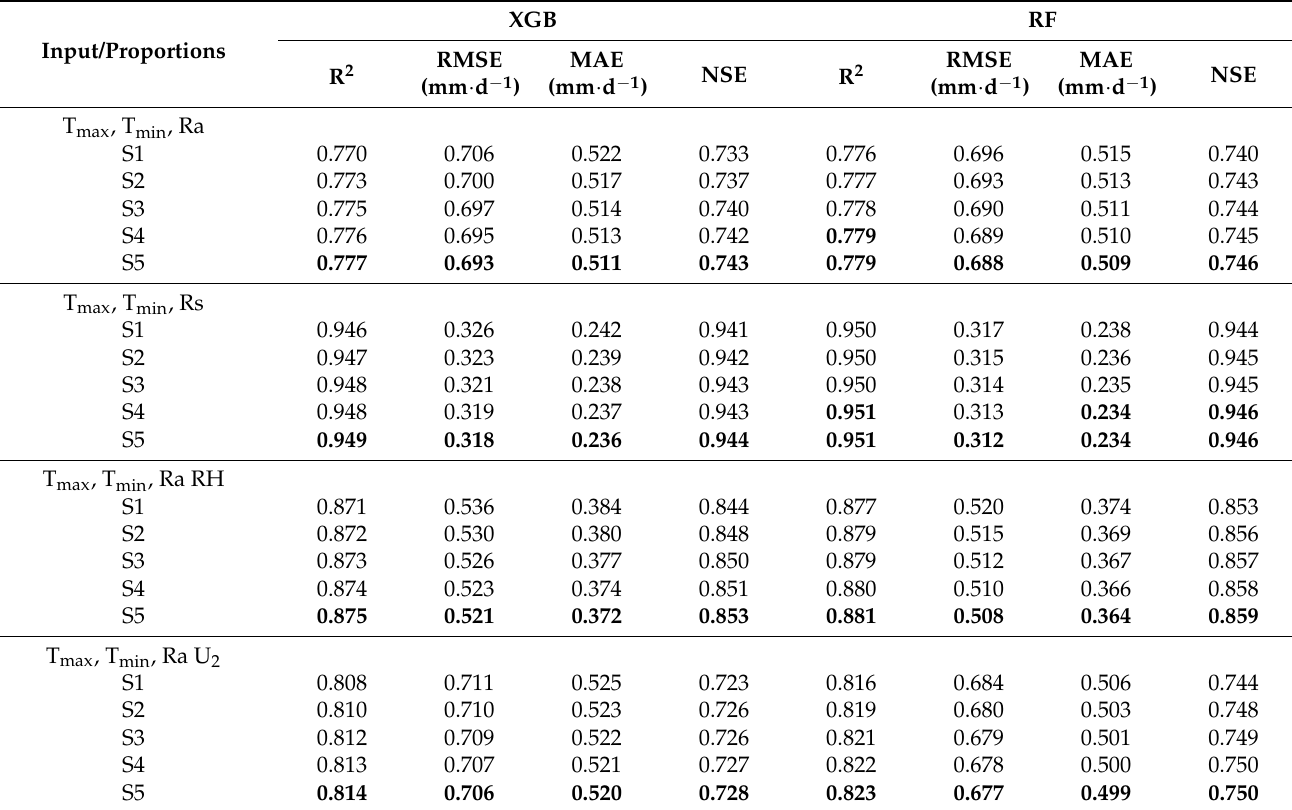
Table 8. Average statistical values of five proportions of different input parameters of two machine learning models